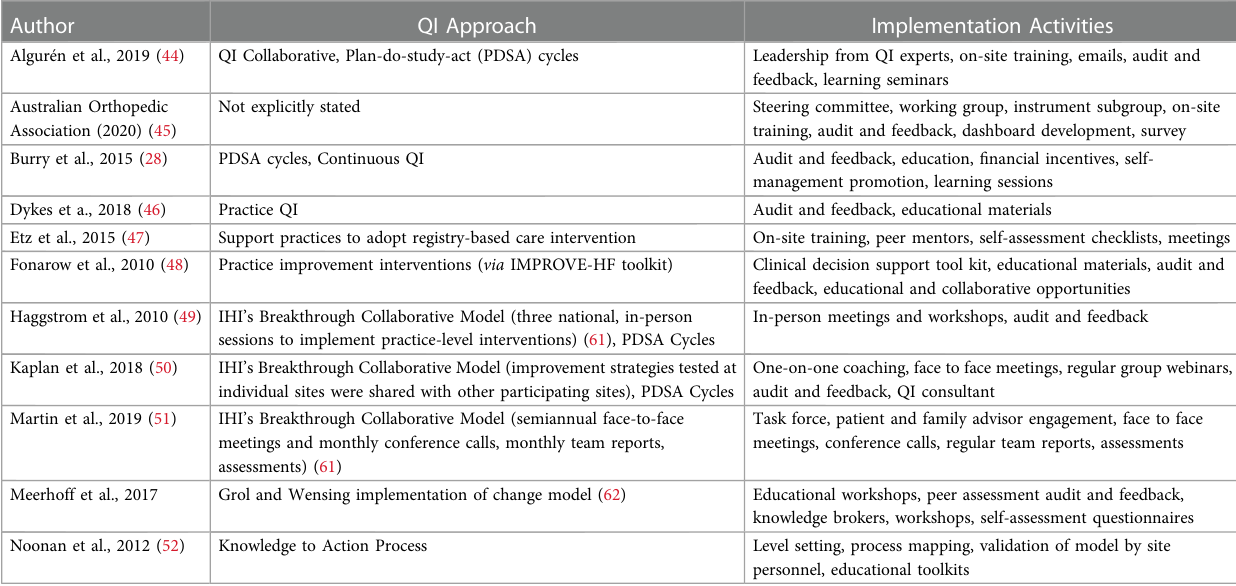
TABLE 2 QI processes informed by registry data.